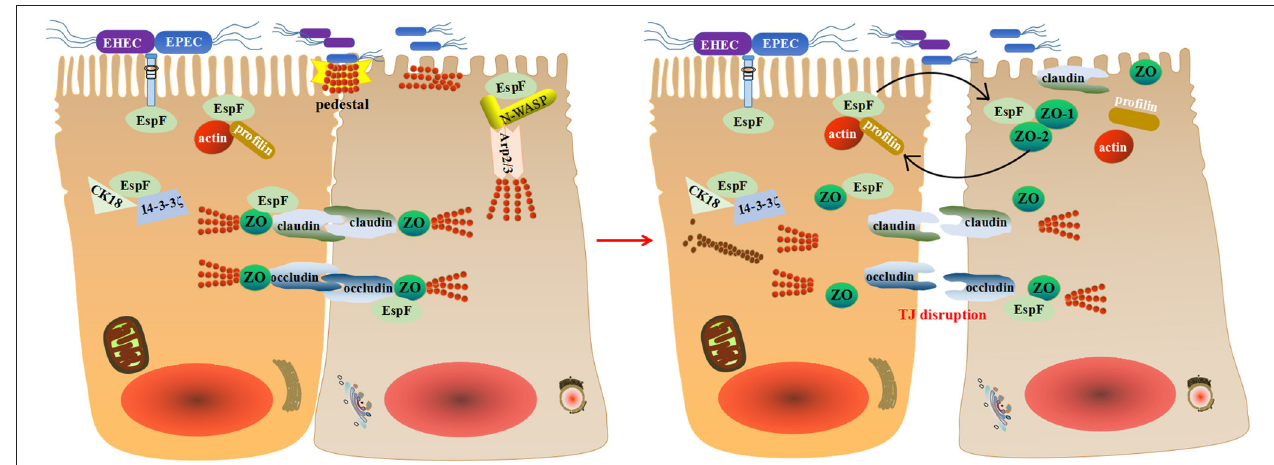
FIGURE 3 | A schematic model for how EspF potentially disrupts tight junctions. EspF interacts with CK18 and 14-3-3 ζ to redistribute intermediate filaments and combines with N-WASP, Arp2/3, actin, profilin, and ZO-1 to recruit junctional proteins to the pedestal. This results in the redistribution of tight junction proteins, depolymerization of actin, and interruption of tight